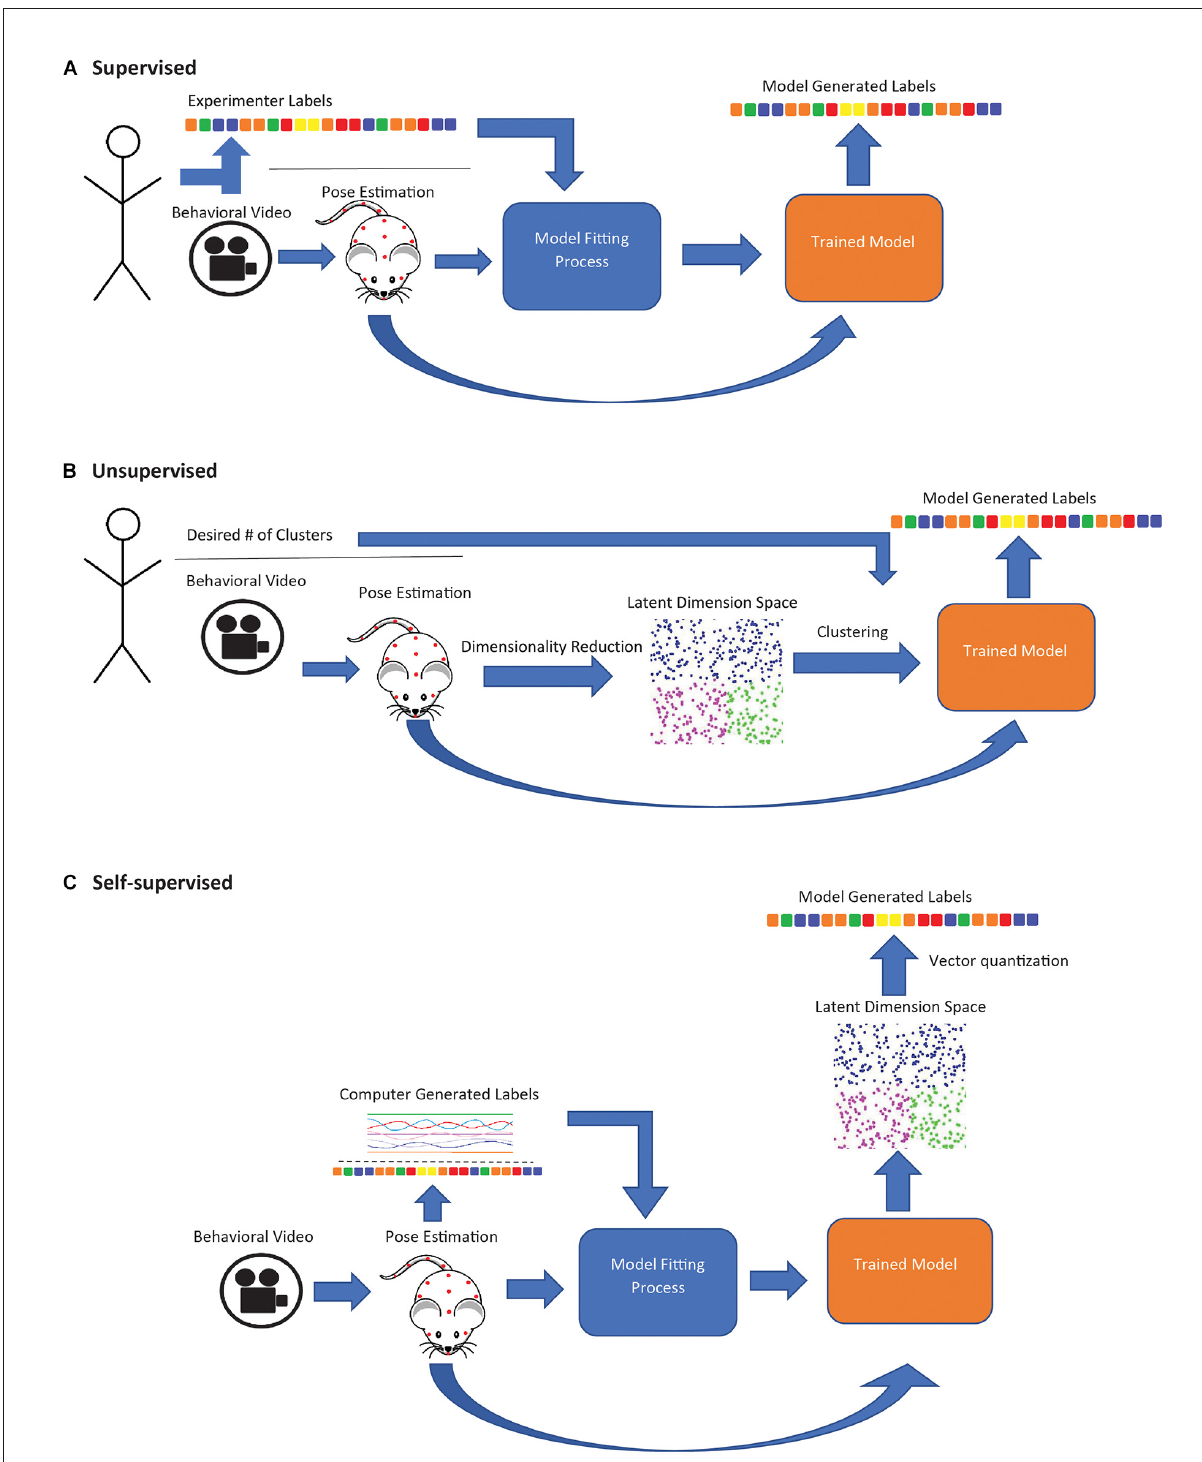
FIGURE1 Schematic diagram of supervised, unsupervised, and self-supervised approaches for animal behavior classification. (A) In supervised approaches, a model is trained to generate behavioral classifiers that replicate human annotations. (B) Unsupervised approaches are entirely data driven; pose estimation data is compressed to the latent state representation and clustered to maximize similarities in data points. Experimenters may sometimes specify the number of desired clusters. (C) In self-supervised approaches, a model is trained to generate labels derived from the data. The trained model is used to map subject behavior to a latent space, and the space is then discretized (usually with